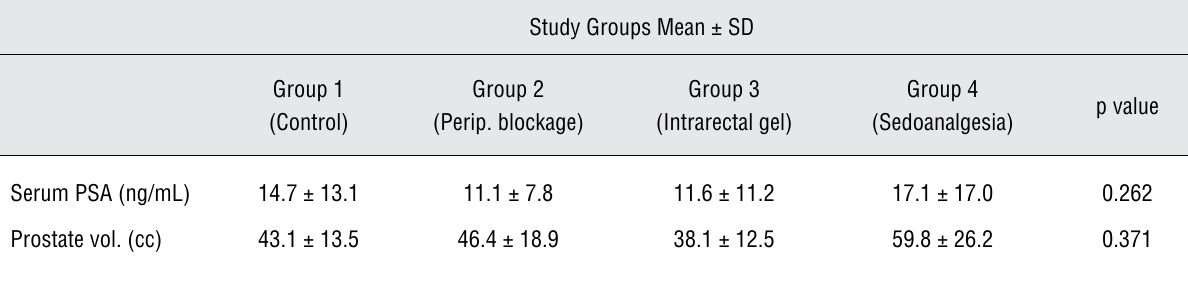
Table 1 - Patients